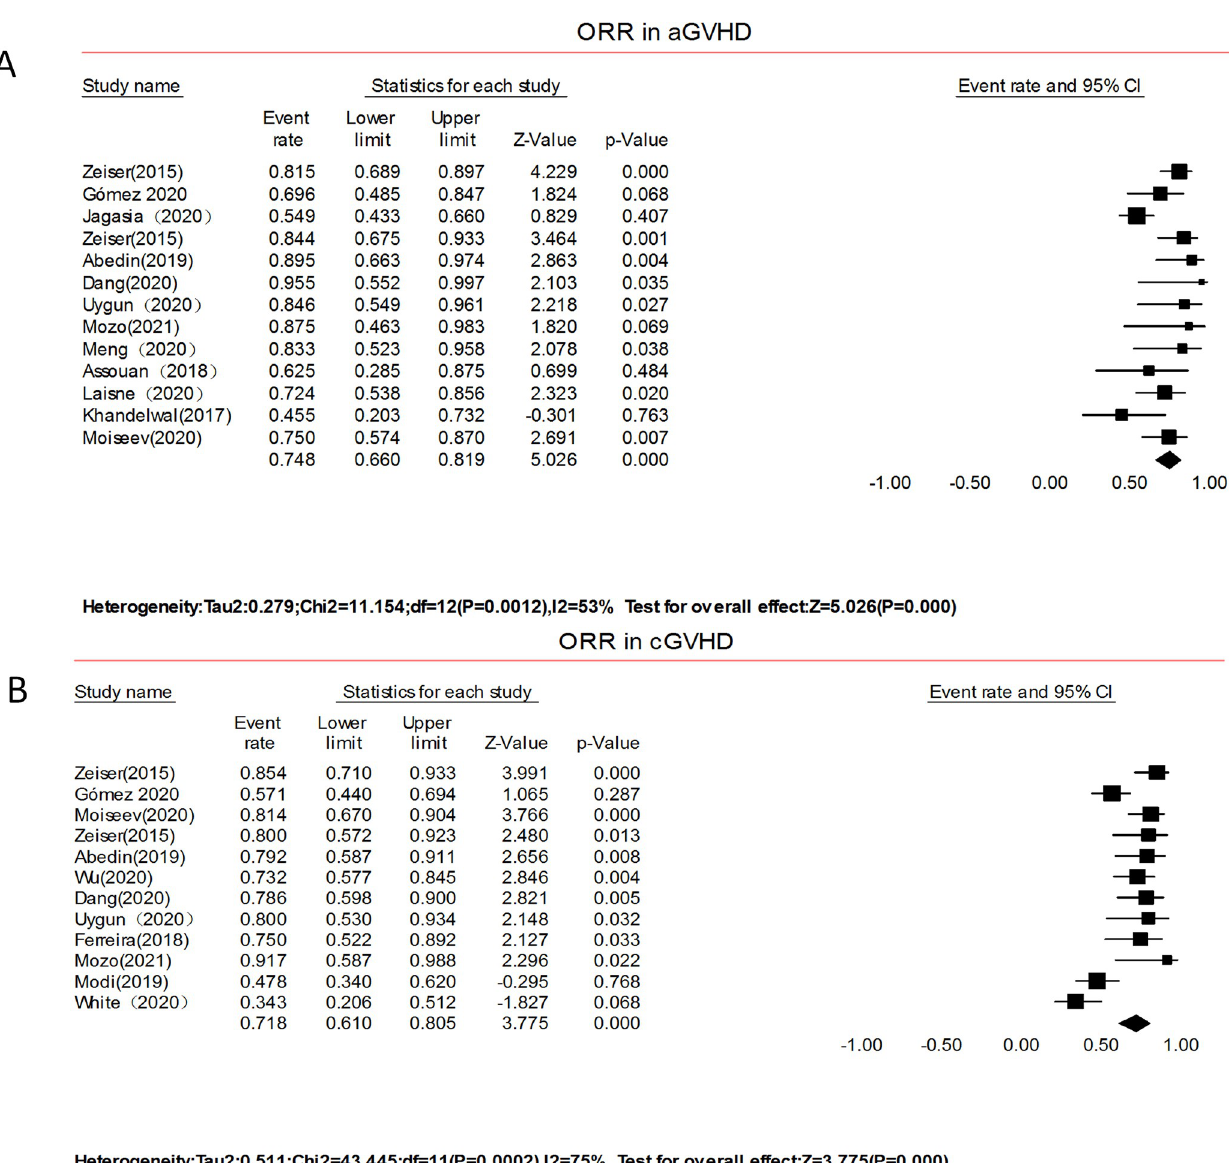
FFS and symptom response. Two randomised phase 3 trials (REACH2 and REACH3) evaluated failure-free survival [30, 31], and both demonstrated that patients receiving ruxoliti- nib had longer failure-free survival than patients receiving control therapy (median failure- free survival in aGVHD, > 18.6 months vs. 5.7 months; HR, 0.37; 95% CI, 0.27–0.51; P < 0.001); median failure-free survival in cGVHD, 5.0 months vs. 1.0 month; HR, 0.46; 95% CI, 0.35– 0.60). In addition, the response to the modified Lee Symptom Scale was only described in patients with glucocorticoid-refractory cGVHD [31]; the ruxolitinib arm at 24 weeks had a higher response than the control group (24.2% vs. 11.0%; OR, 2.62 [95% CI, 1.42 to 4.82]; RR, 2.19 [95% CI, 1.31–3.65]; P = 0.001).